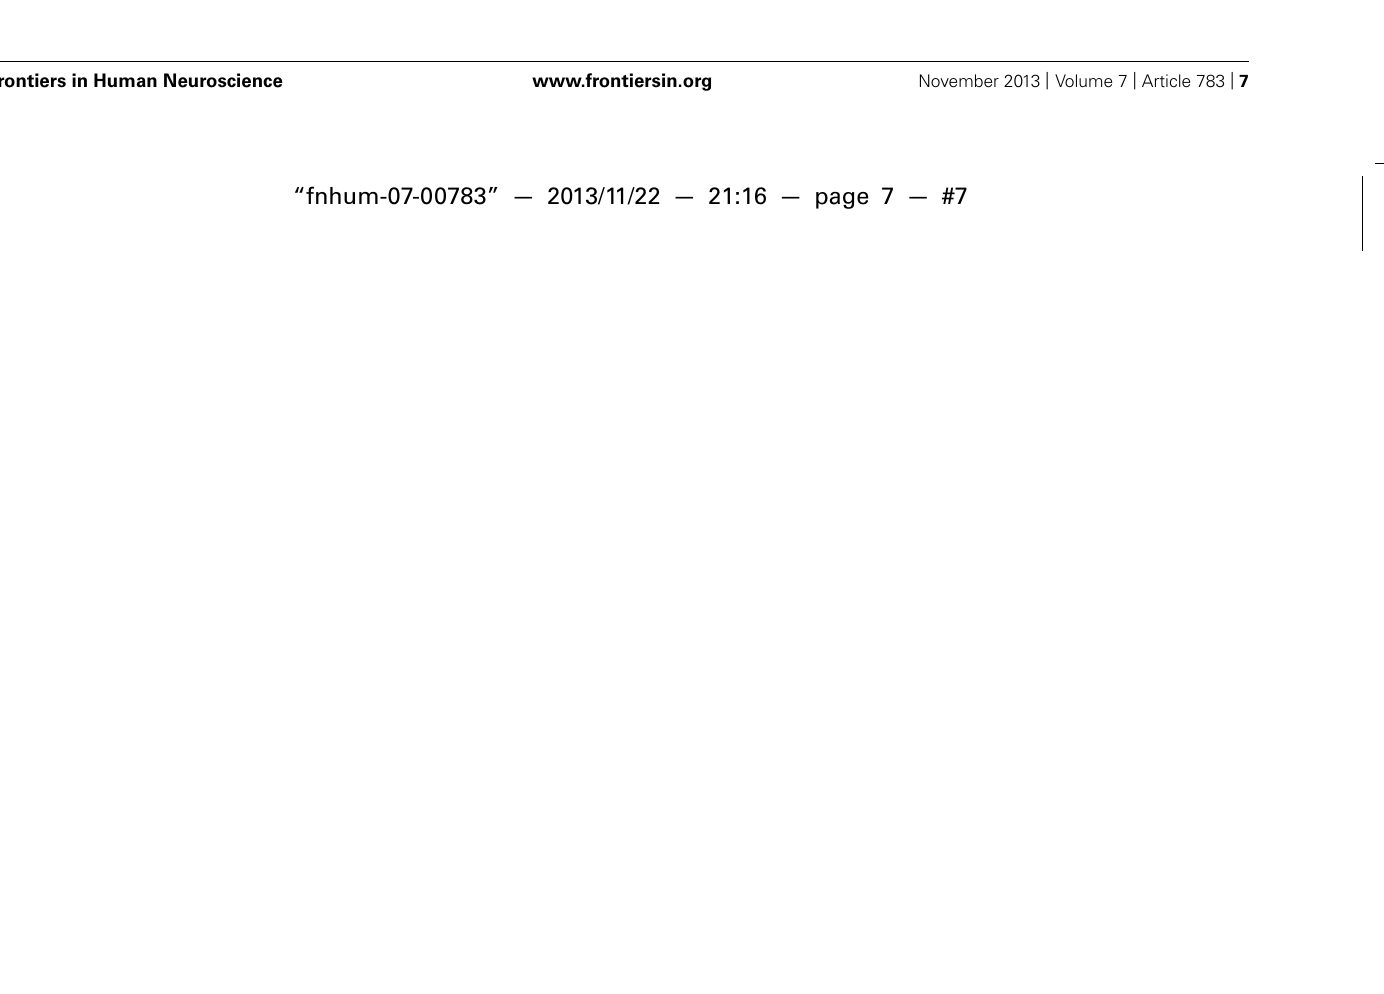
stimulation of the ampullary crests (Brandt and Steddin,